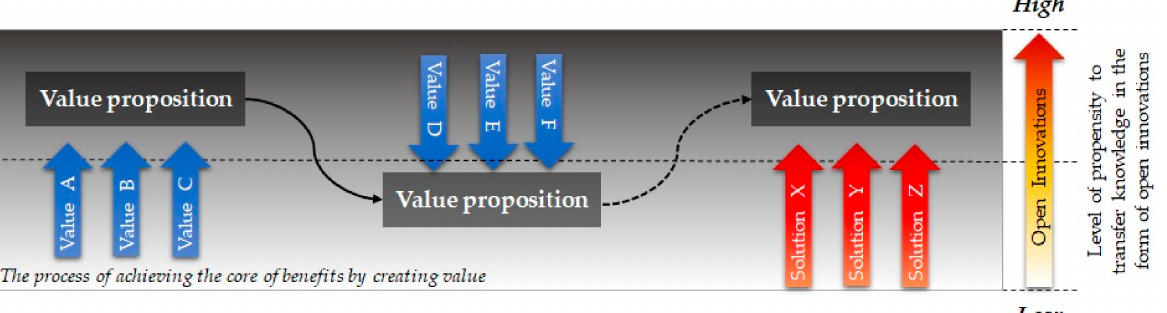
Figure 4. Hypothetical impacts of values in the business model on the course of changes in the tendency of managers to transfer knowledge in the form of open